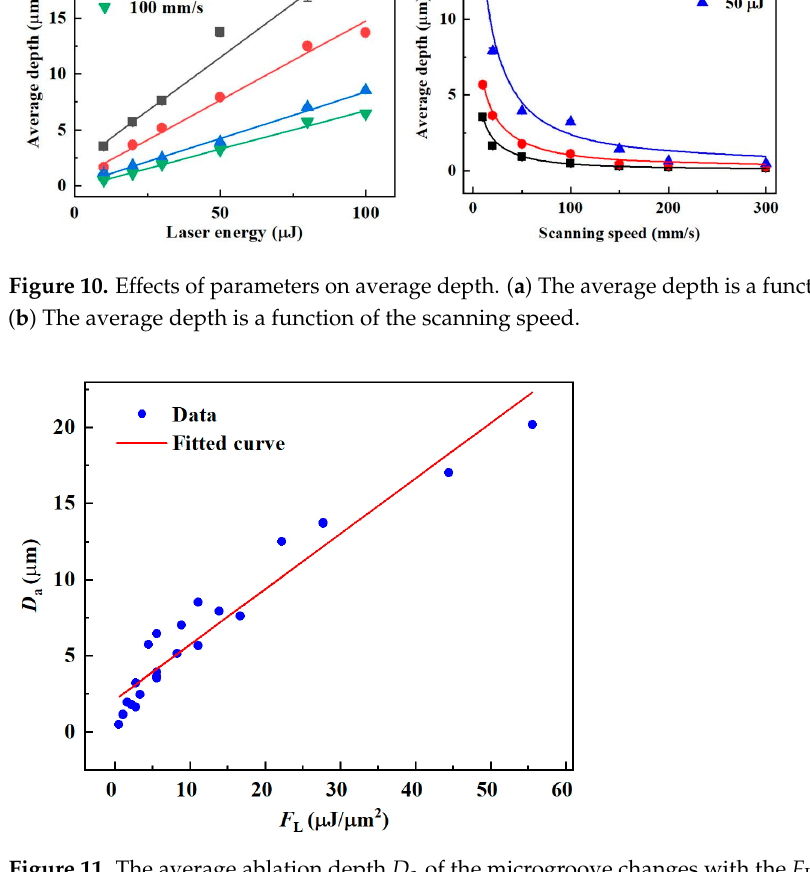
Figure 11. The average ablation depth D a of the microgroove changes with the F L